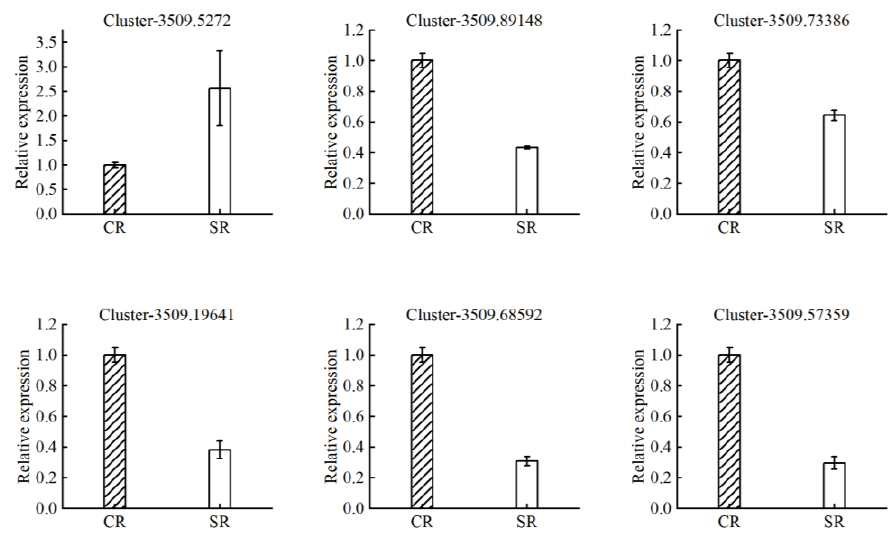
Figure 4. Analysis of gene expression in water lily roots under control conditions (CR) and 150 mM NaCl treatment (SR) using RT-qPCR. Actin was used for normalization.